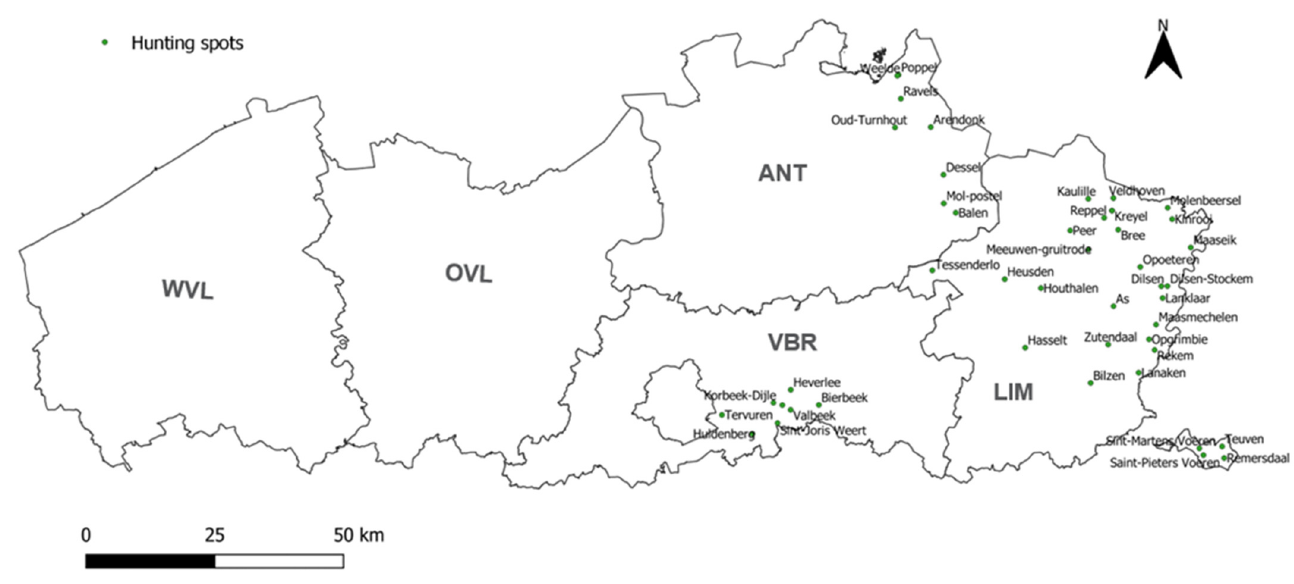
Figure 2. Geographical repartition of the 50 wild boar hunting spots where sera were collected between May 2019 and October 2020. The 5 Flemish provinces are indicated in bold. WVL: West Flanders, OVL: East Flanders, ANT: Antwerp, LIM: Limburg, VBR: Flemish Brabant. The 4 isolated spots in the bottom right (Teuven, Remersdaal, Saint-Pieters Voeren, and Sint-Martens Voeren) belong to the province of Limburg.